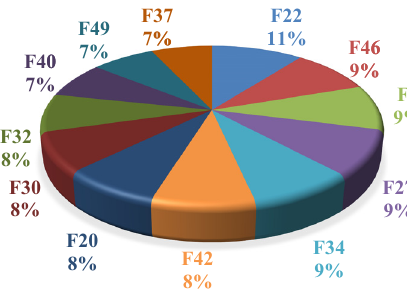
Figure 6: Local impact of factors in the design stage.